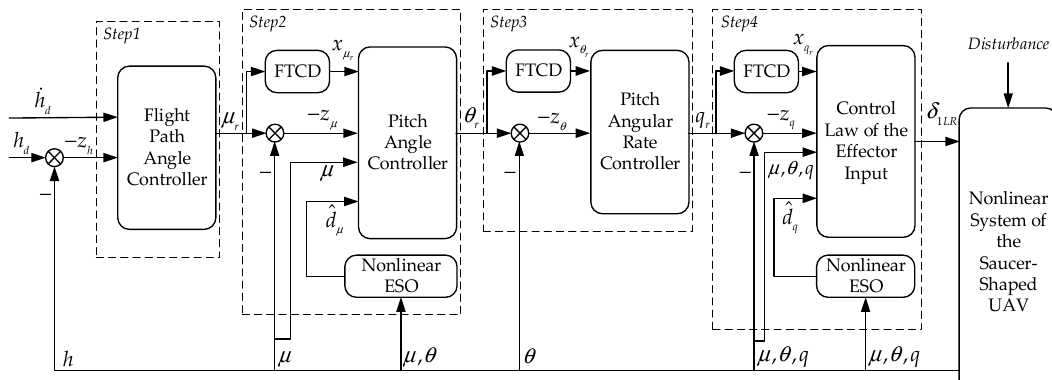
Figure 2. Structure diagram of the proposed control scheme (detailed definition of the symbols in the figure can be found in Section 3.3).